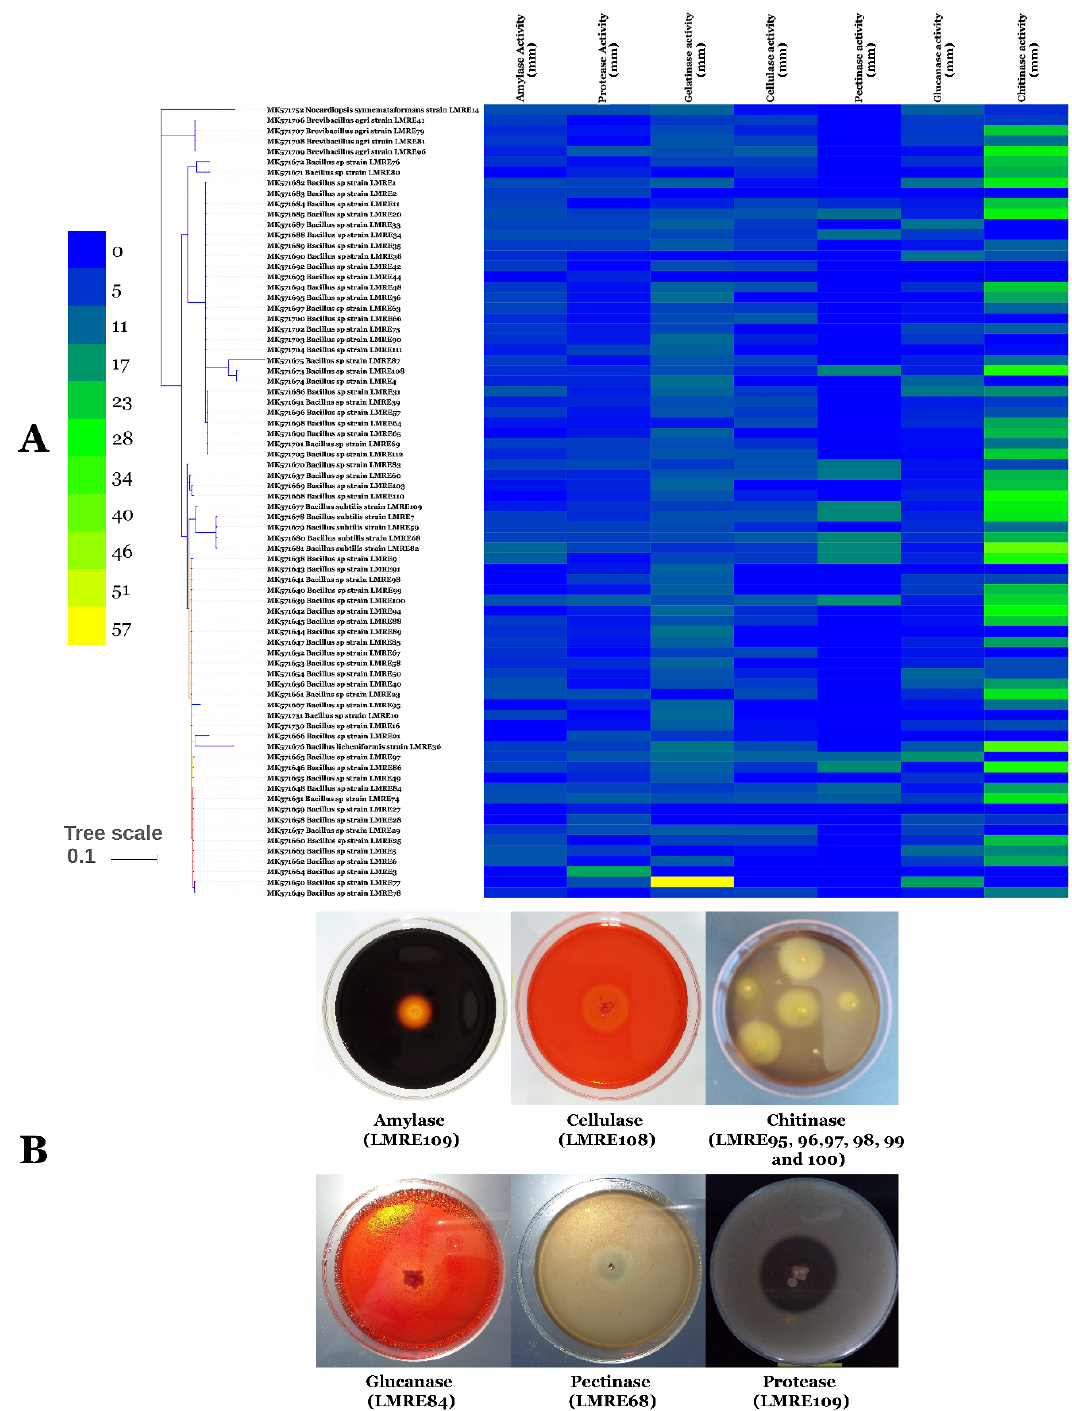
Figure 4. ( A ) Heat-map and ( B ) in vitro extracellular enzyme (amylase, protease, gelatinase, cellulase, pectinase, glucanase and chitinase) activity of Gram-positive bacterial isolates.